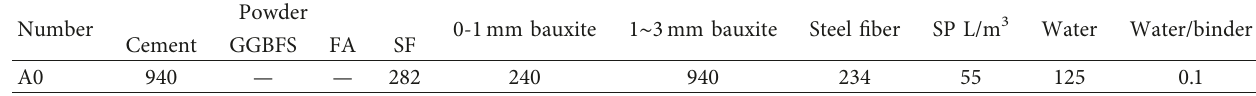
Table 1: The mix proportion of the control specimen (kg/m 3 ).